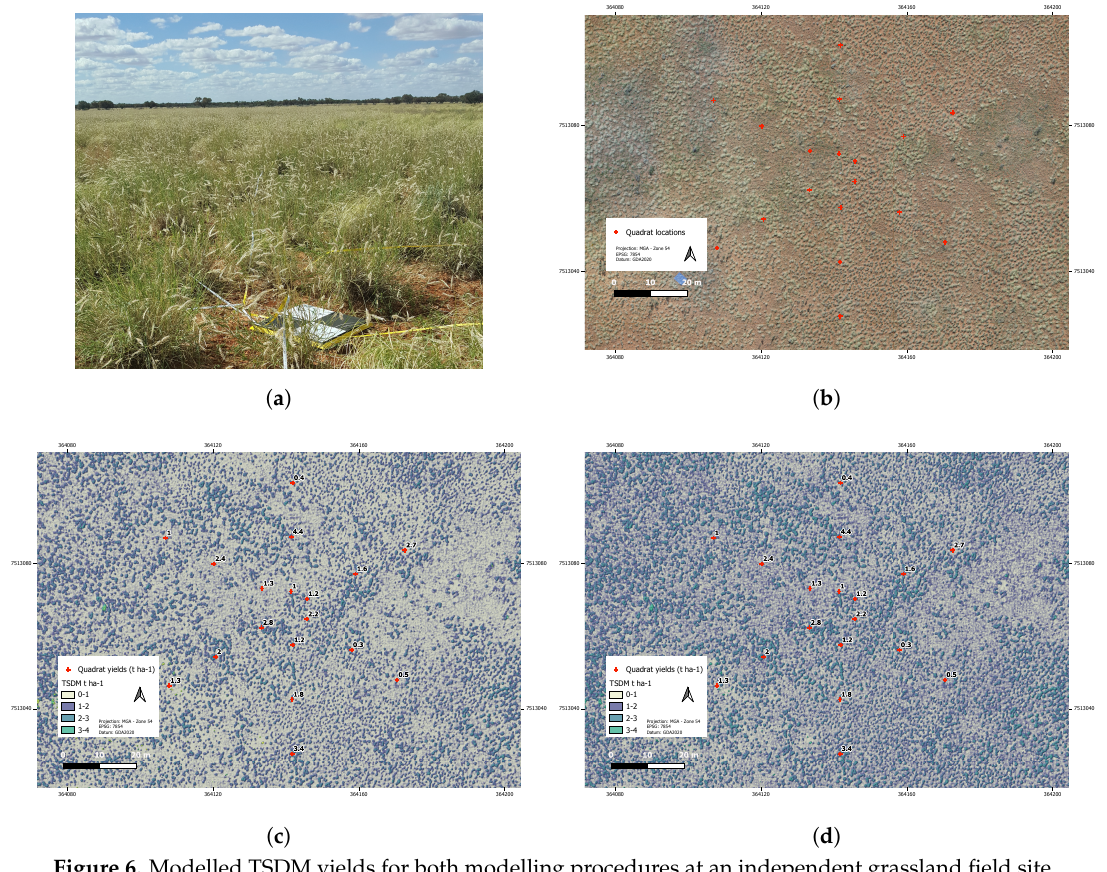
Figure 6. Modelled TSDM yields for both modelling procedures at an independent grassland field site. Photograph ( a ) is first an example of the field sites pasture from its centre point, next map ( b ) illustrates the orthomosaic image of the field site and finally maps ( c , d ) illustrate the automatic ML and robust regression models of TSDM t ha − 1 applied to the PH UAV modelled surface. Individual field sampled quadrats are further illustrated as red crosses across both maps ( b , c ) along with their field measured TSDM t ha − 1